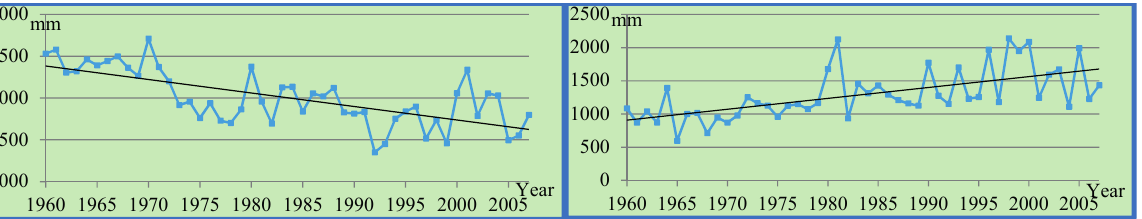
Figure 12. The most significant negative trend with a slope of − 16.178 ( left ) and the most significant positive trend with a slope of 16.367 ( right ) of the PRCPTOT